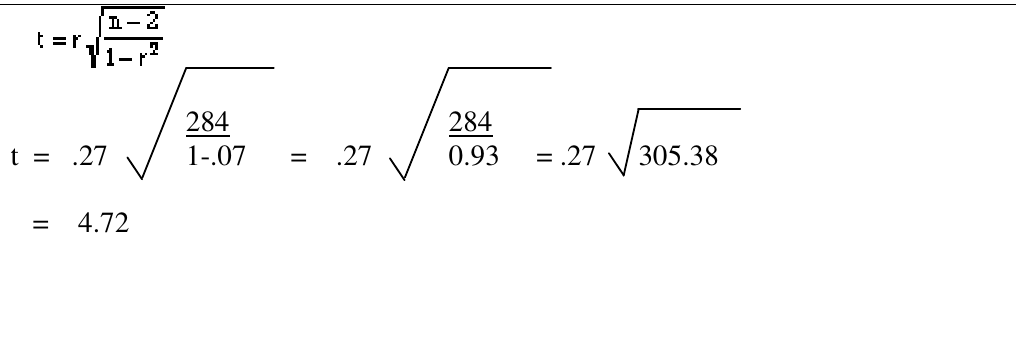
Table 4: Computation of t-value to test significance of correlation coefficient